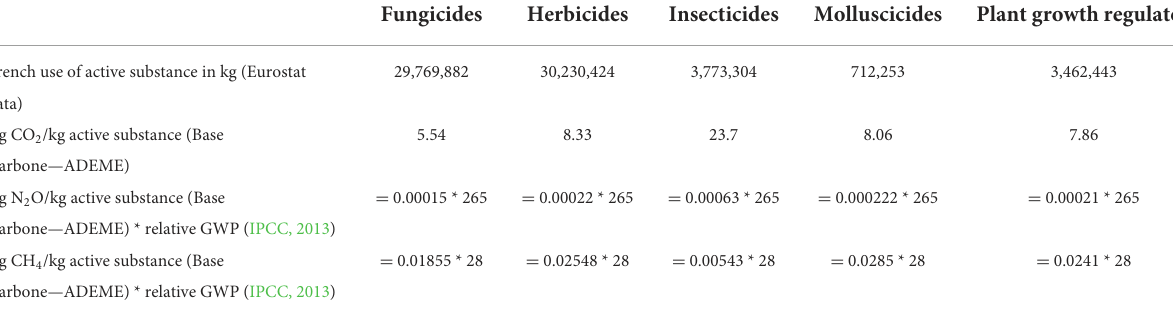
TABLE 6 Summary of the quantified estimates obtained for the social costs associated with synthetic pesticide use in